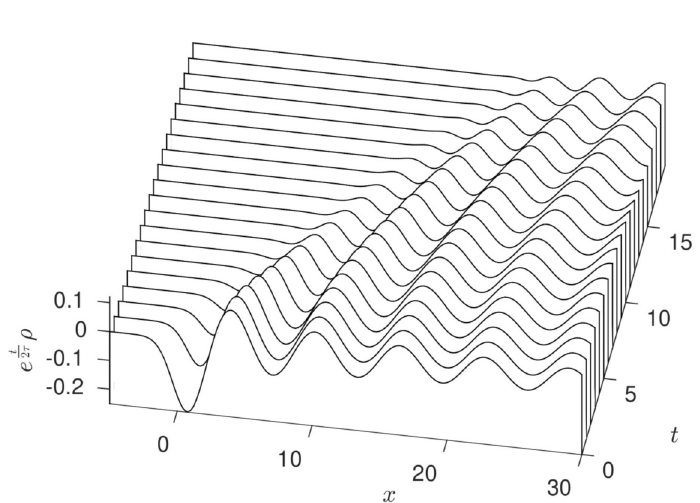
Figure 9 . Spacetime evolution of e t 2 τ ρ ( t, x ) for the initial data (4.1) with s = 1 . We have multiplied by e t to factor out the leading late time decay of the wave (recall that D = τ = 1 / 2 in 2 τ our numerical